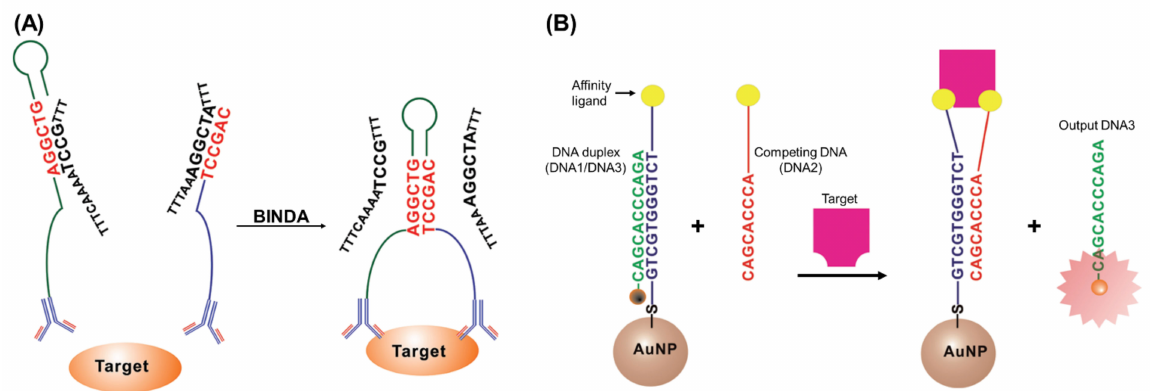
Figure 7. ( A ) Conceptual scheme of binding-induced DNA assembly (BINDA). Adapted with permission from Anal. Chem. 2012, 84, 877–884, doi:10.1021/ac203207g. Copyright (2012) American Chemical Society [53]. ( B ) Principal scheme of a biosensor based on bivalent interaction-induced DNA displacement on AuNPs. Reproduced by permission from John Wiley & Sons Ltd.: